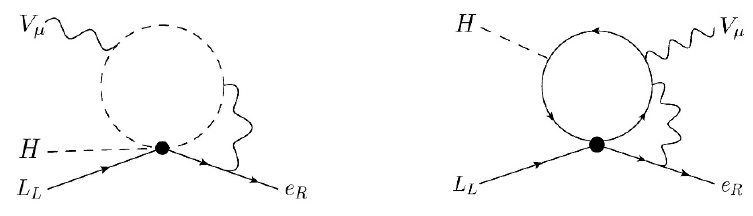
Figure 2 . Feynman contributions to the anomalous dimension of level from (left) and (cid:22) d (cid:22) q , (cid:22) l 0 O y e O le O le (cid:22) e 0